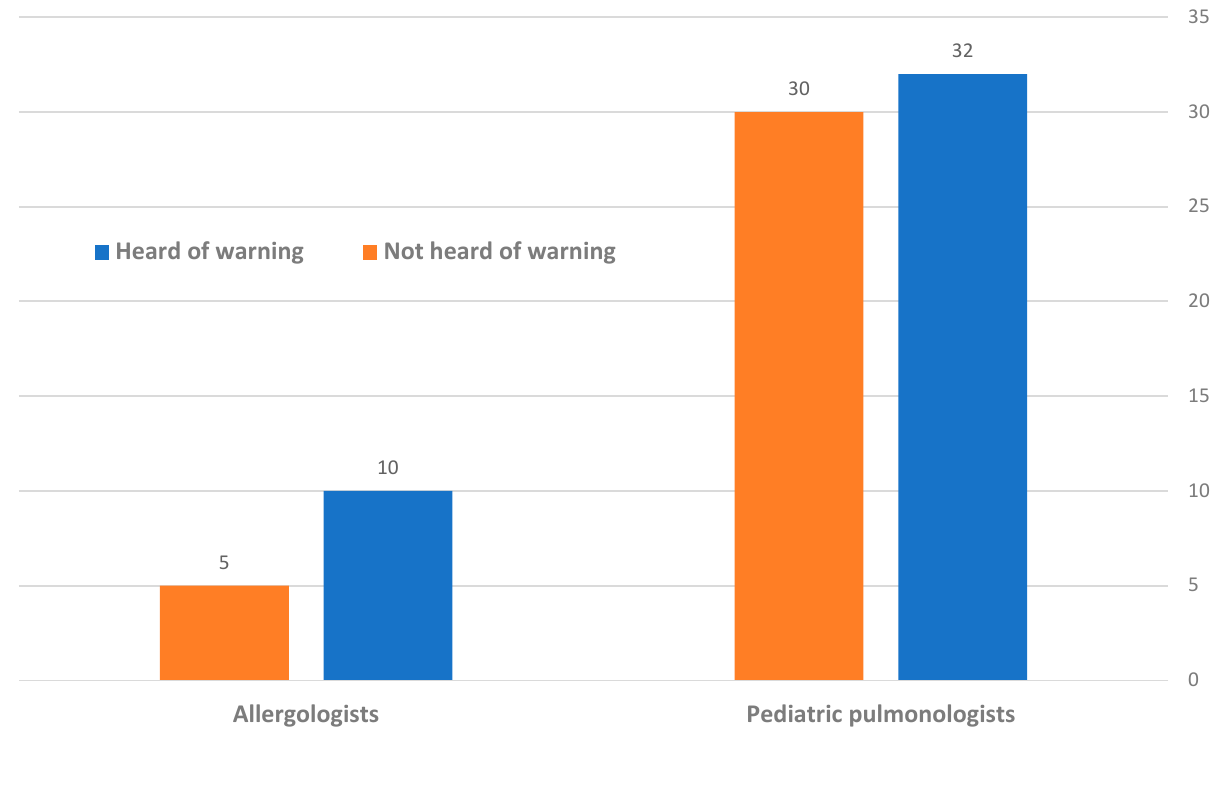
Figure 3. Division of the awareness to the warning of Dry-Powder Inhaler administration in CMPA, according to speciality.